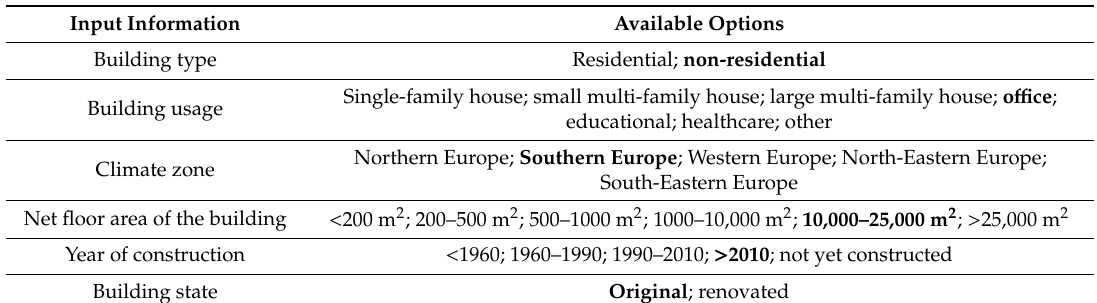
Table 2. Excel-based calculation tool. Choice of input information (in bold in the table) to describe the case study